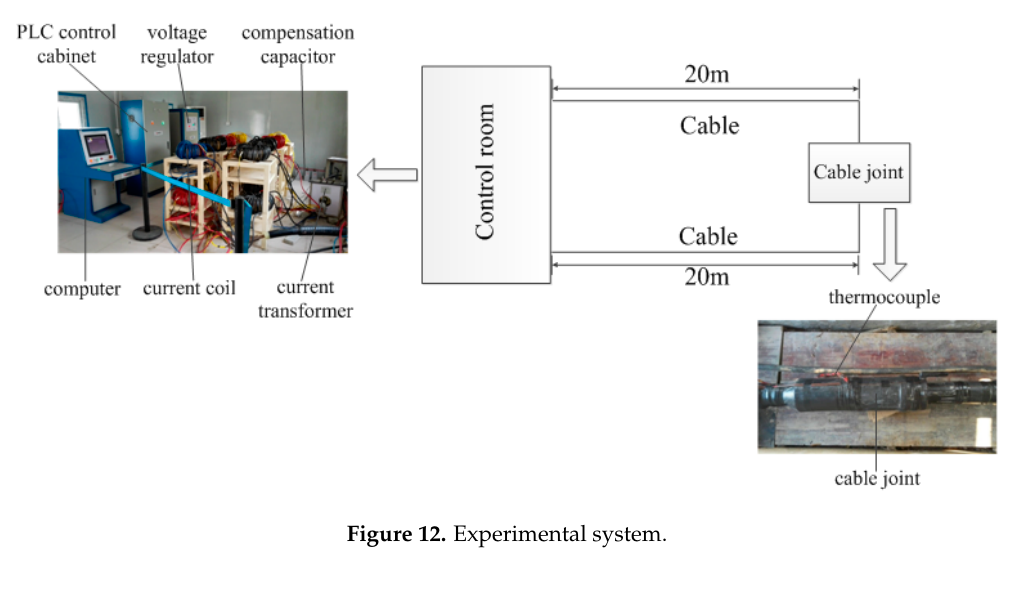
Figure 12. Experimental system.